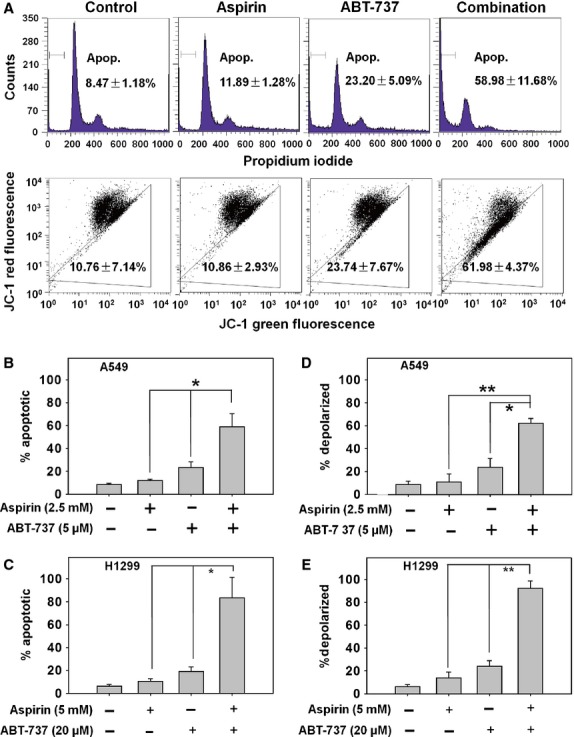
Long-term combination treatment with aspirin and ABT-737 caused enhanced apoptosis. (A) A549 cells were treated with aspirin (2.5 mM), ABT-737 (5 μM) or the combination for 48 hrs. Cells were stained with PI (upper) or JC-1 (bottom) and analysed by flow cytometry. A549 (B) and H1299 (C) cells in six-well plates were exposed to the compounds for 48 hrs and then cells were analysed by flow cytometry after PI staining. A549 (D) and H1299 (E) cells in six-well plates were exposed to compounds for 48 hrs and then cells were analysed by flow cytometry after JC-1 staining. The experiments were repeated three times and error bars represented standard deviation. *P < 0.05, **P < 0.01.